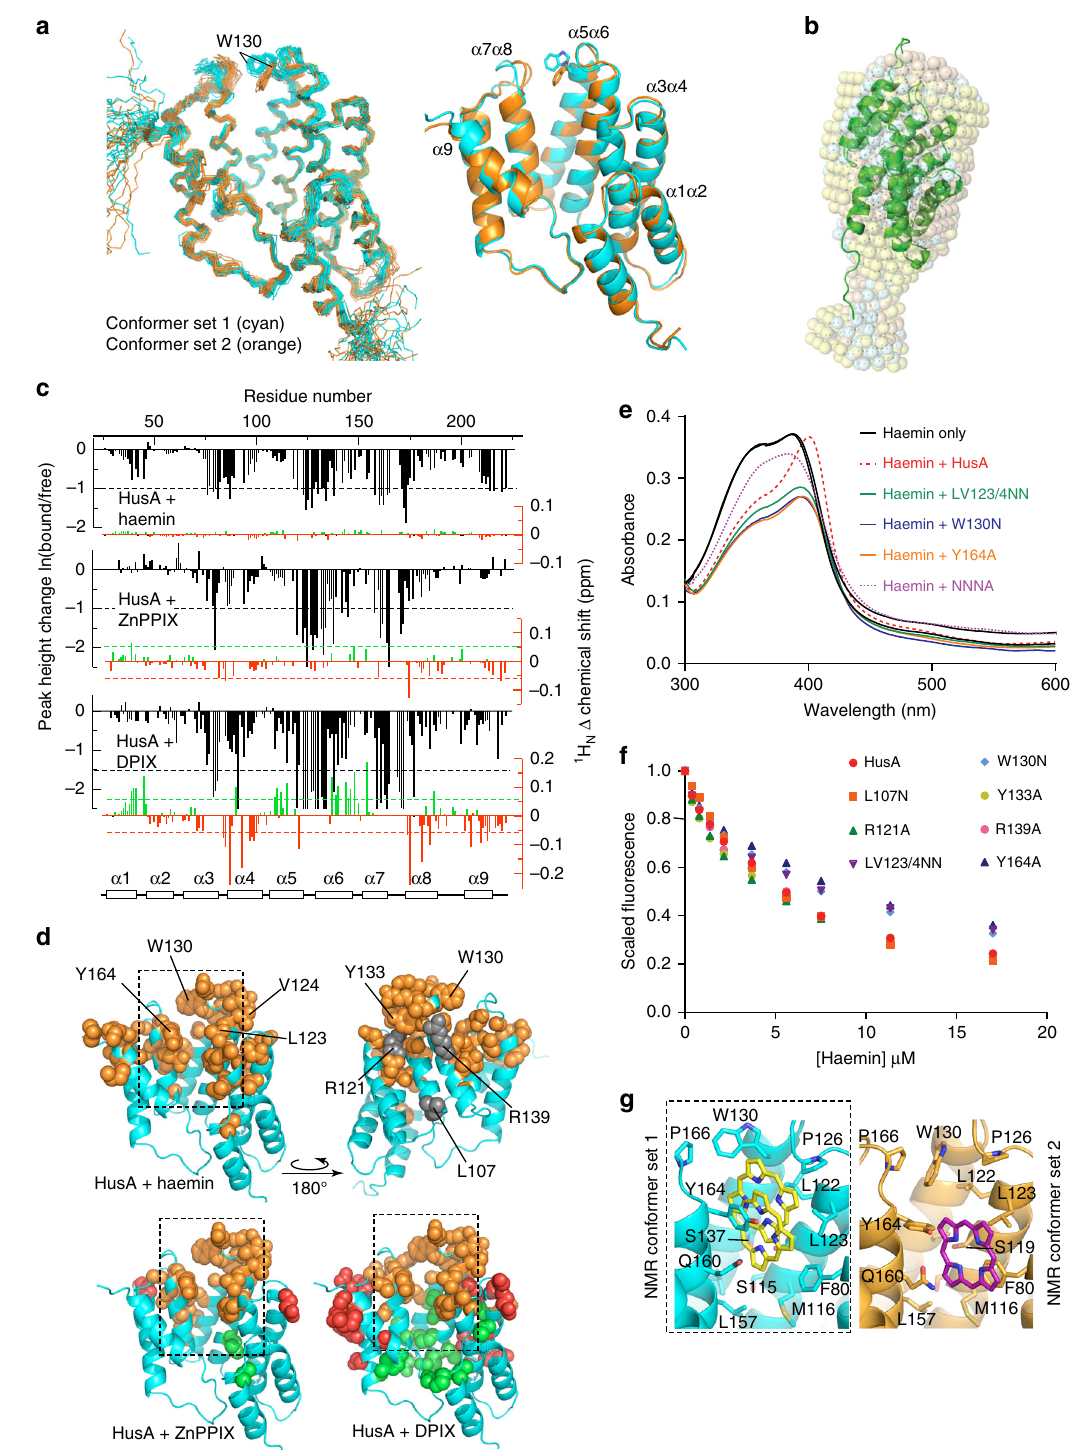
ligate ferric haem through tyrosine (Supplementary Figure 16) 21,22 . Furthermore, when we mutated the haem coordinating tyrosine in IsdH (Y642A), the resulting mutant bound haem non- covalently and displayed acid-alkaline transition (pKa 5.9) which was very similar to rHusA (Supplementary Figure 16). Taken together, these results suggest that haemin binds to HusA as a fi ve-coordinate Fe(III) complex with an axial water/hydroxide. Lack of evidence for iron coordination by a protein side chain makes HusA unusual amongst bacterial haem binding